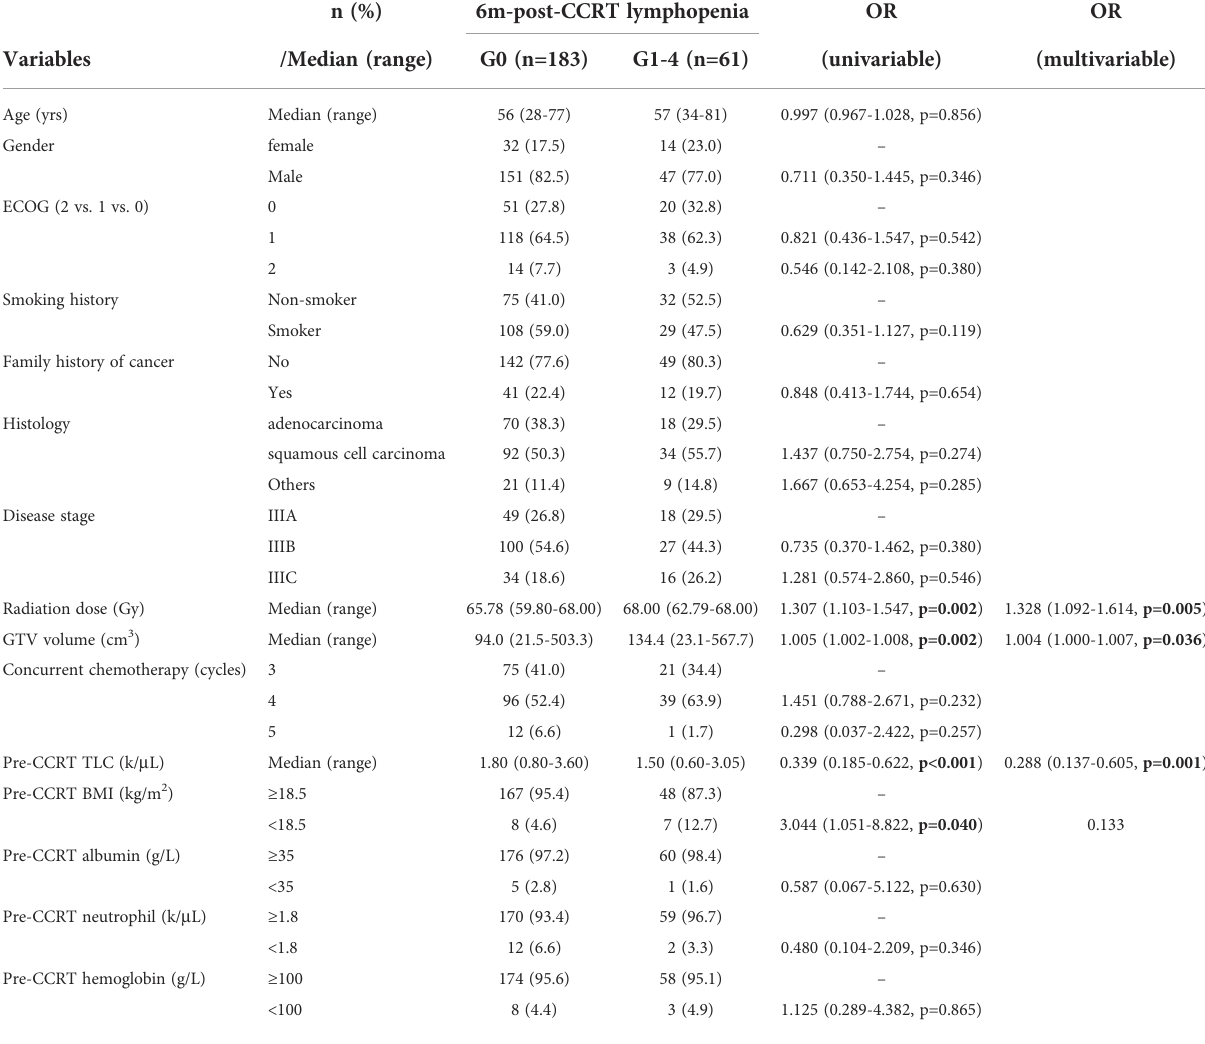
TABLE 4 Binary logistic regression results of variables related to persistent lymphopenia at 6 months after CCRT. n